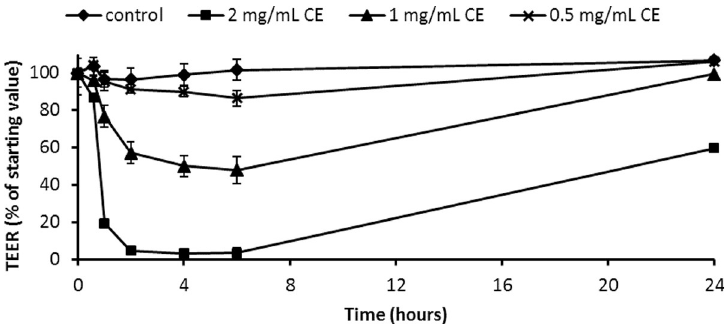
Fig 1. Changes in transepithelial electrical resistance induced by A . simplex crude extract. Caco-2 cells were cultured using DMEM-galactose for 15 days to reach differentiation and were exposed to 2, 1 and 0.5 mg/mL CE. TEER was measured at different time points and the results are expressed as mean ±